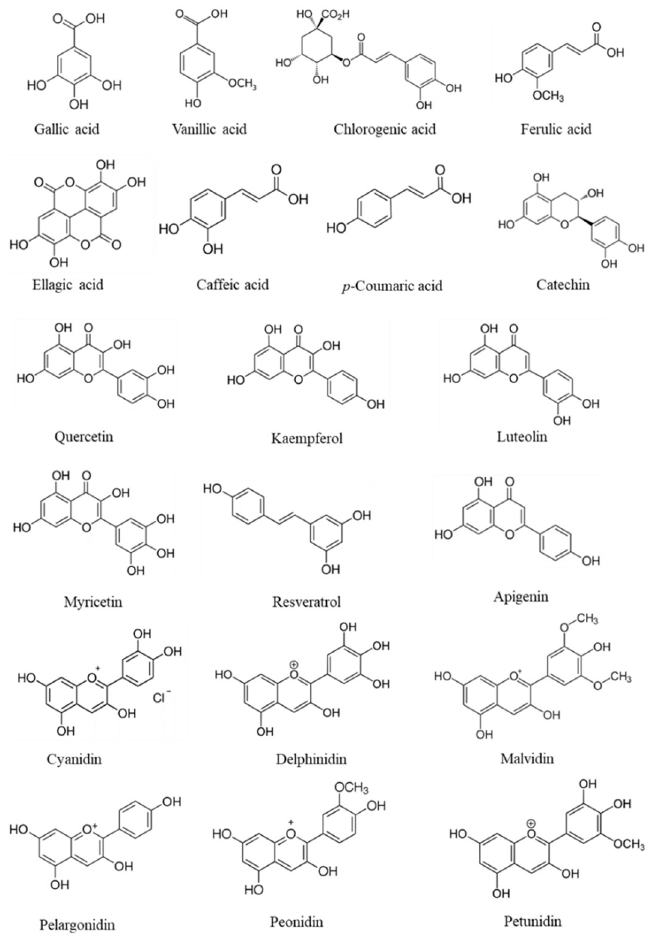
Figure 3. Chemical structures of phenolics that are commonly found in fruits.